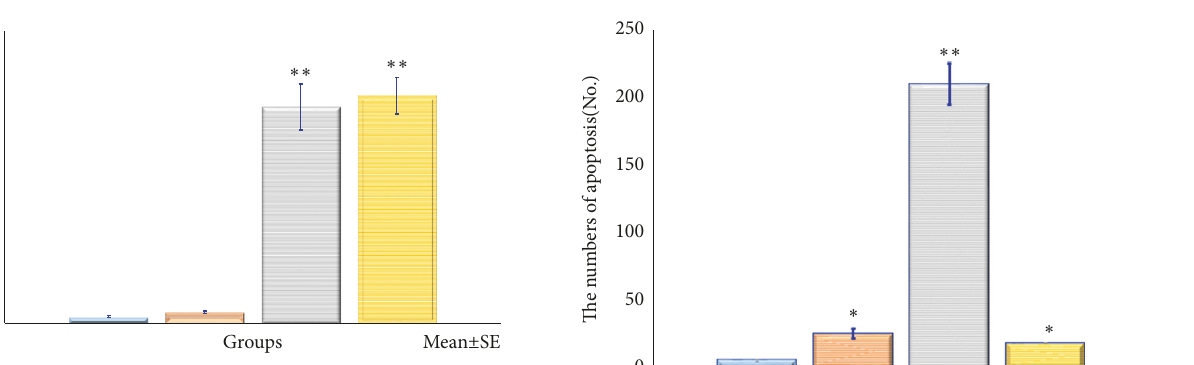
Figure 12: The number of cells undergoing apoptosis after elec- trochemical therapy in 6hr after treatment. The distribution of apoptosis of the tumor. Quantitation was performed as described in thetextandthedistributionofapoptoticbodiesexpressedinrelation to position on the tumor cells. Significantly different ∗∗ p < 0.01 , control vs . 10mA × 150sec, 10mA × 300sec, and 10mA × 600sec. The results represent ± S.D. from 8 to 10 mice.